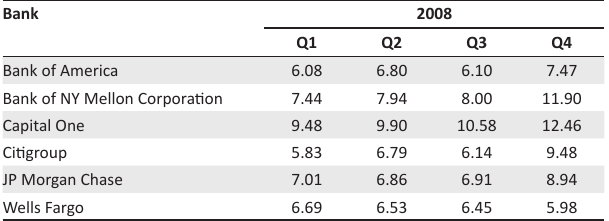
TABLE 1: Tier 1 capital ratios for banks in the United States for the first four quarters of 2008.